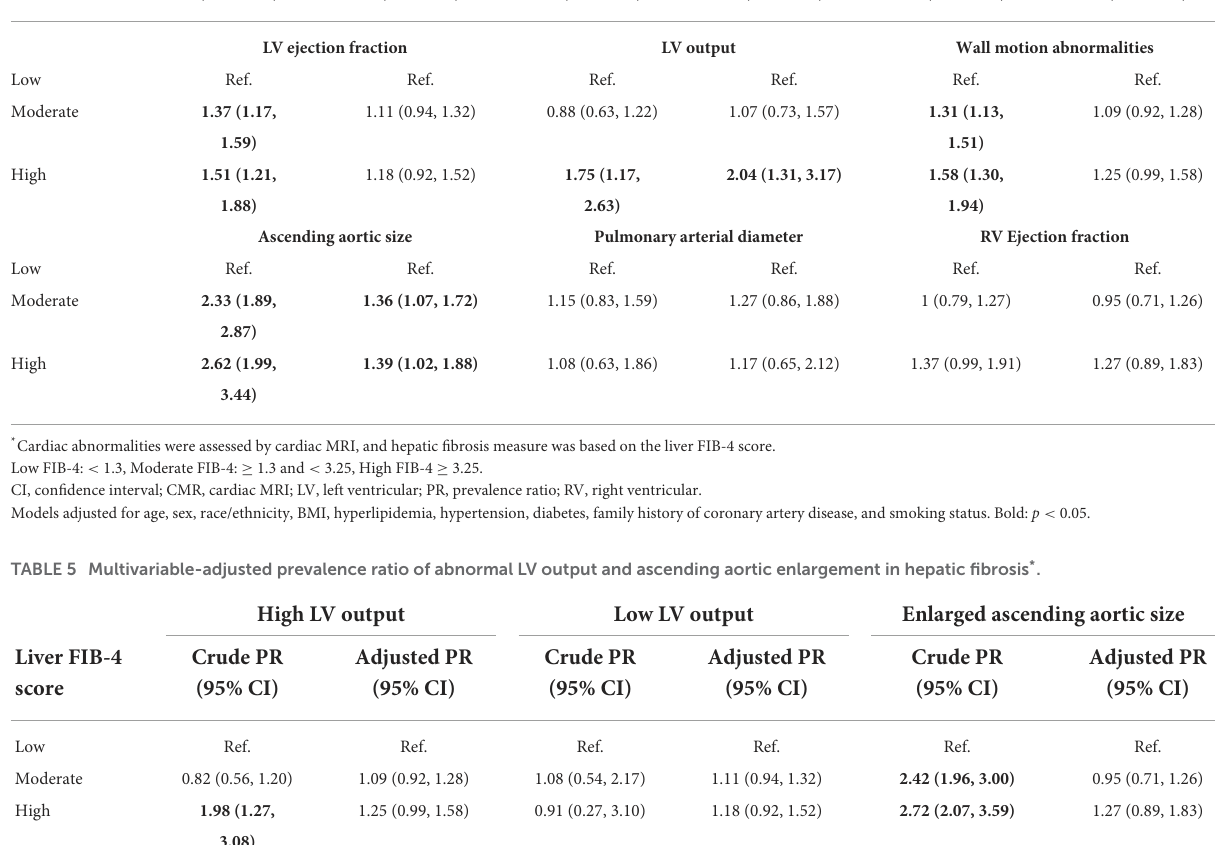
TABLE 4 Multivariable-adjusted prevalence ratio of cardiovascular abnormalities in association with hepatic fibrosis * , by sub-component. Liver FIB-4